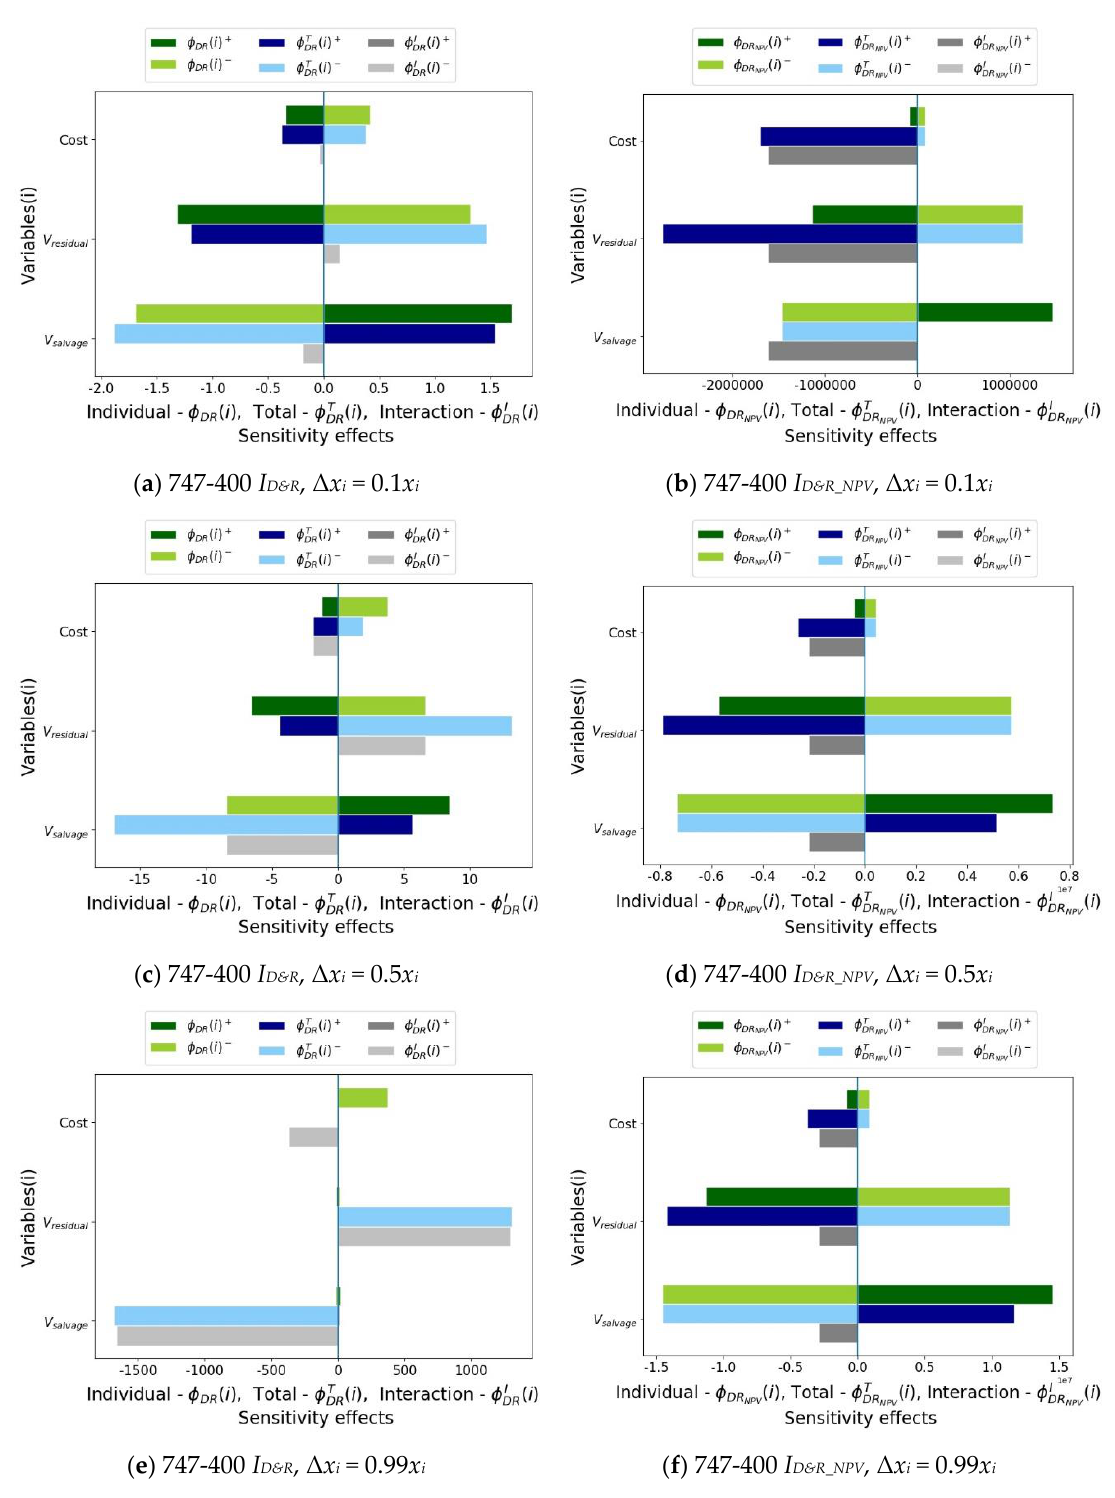
Figure 6. Sensitivity tornado diagram (747-400 resale).